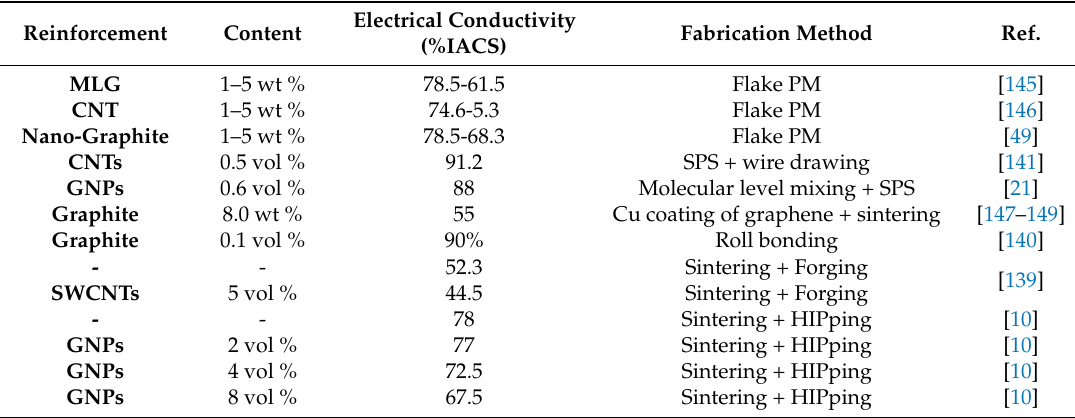
Table 4. A summary of the electrical conductivity reports for Cu-GNPs